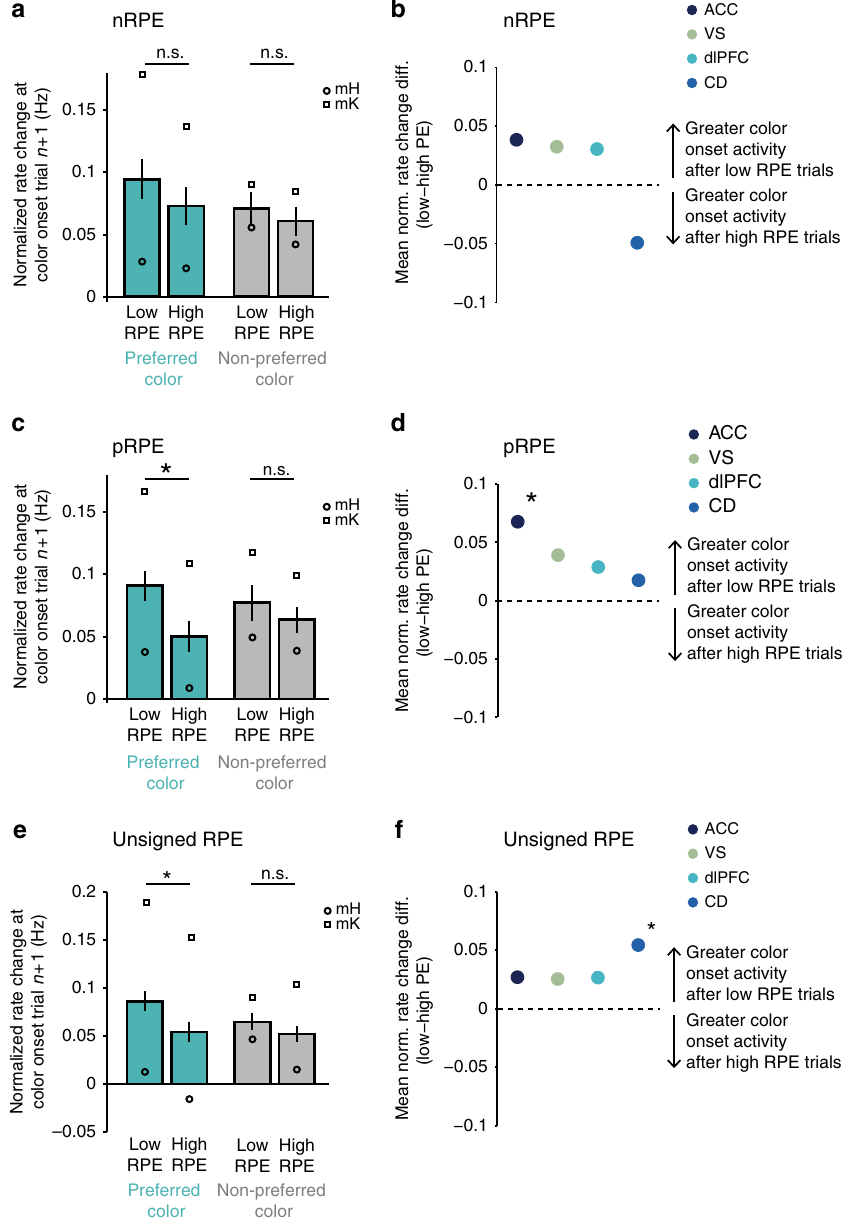
Fig. 9 Firing rate increases at color onset following low- vs. high-RPE trials. a , c , e Average normalized fi ring rate changes from pre to postcolor onset in trial n + 1 across neurons encoding color-speci fi c negative RPE ( a , n = 114), positive RPE ( c , n = 140) and surprise (unsigned RPE) ( e , n = 260). Rate changes were computed according to Eq. (13) in Supplementary Methods and normalized to range from − 1 to 1. Averages were computed separately for the 25% of trials with the greatest prediction errors and for the 25% of trials with the lowest prediction error, in cyan following preferred color choices and in gray following nonpreferred color choices. Circles indicate means for monkey H, squares indicate means for monkey K. Error bars indicate SEM. b , d , f Mean differences in normalized rate changes following low vs. high RPEs for the preferred RPE color (cyan in a , b ) for each area across color-speci fi c negative RPE ( b ) positive RPE ( d ), and unsigned RPE ( f ) encoding neurons. Black asterisks indicate signi fi cant differences in rate changes following low vs. high RPEs (paired t test, p <